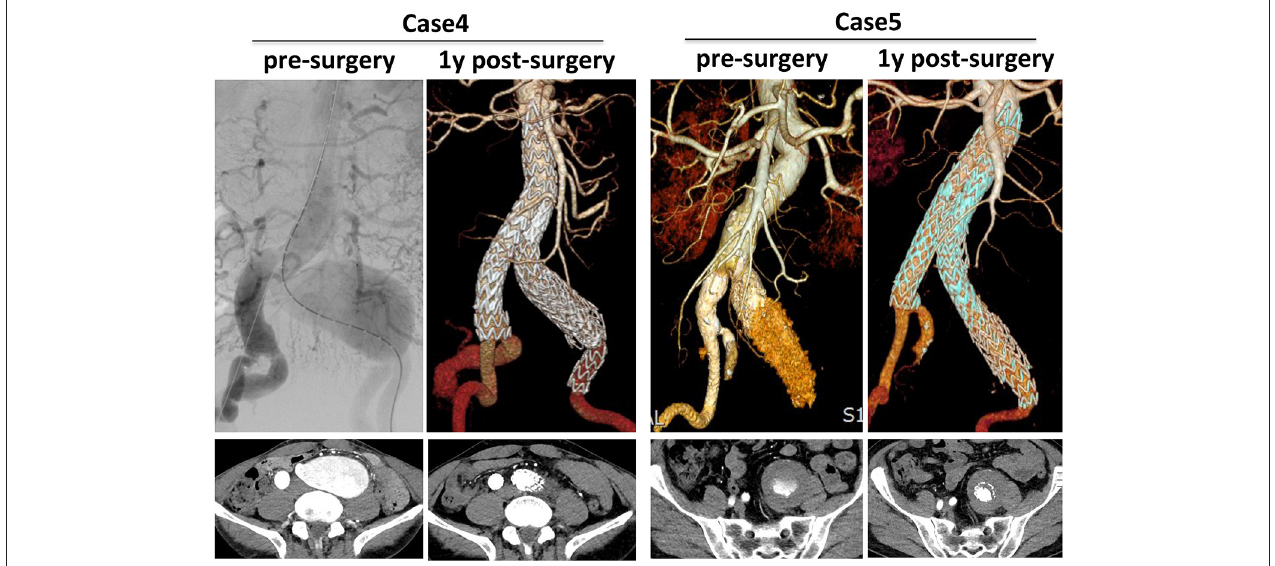
FIGURE 3 | Typical cases of CST for isolated iliac aneurysms. 3D CTA pre-surgery and 1-year post-surgery was compared and corresponding transverse section was also presented.